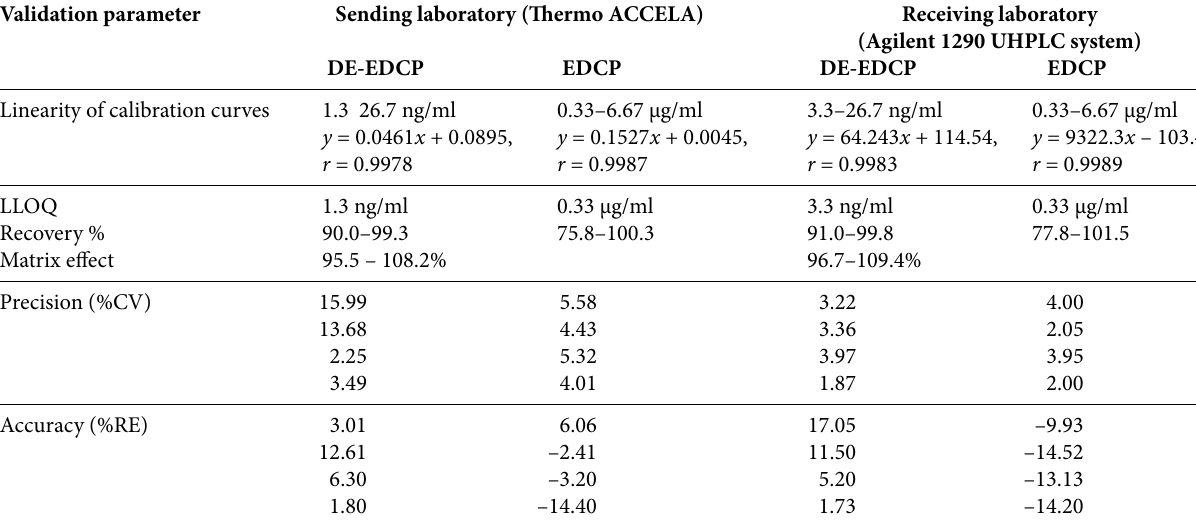
Table 2: Validation parameters for the DE-EDCP and EDCP on the Thermo ACCELA and the Agilent 1290 UHPLC system Validation